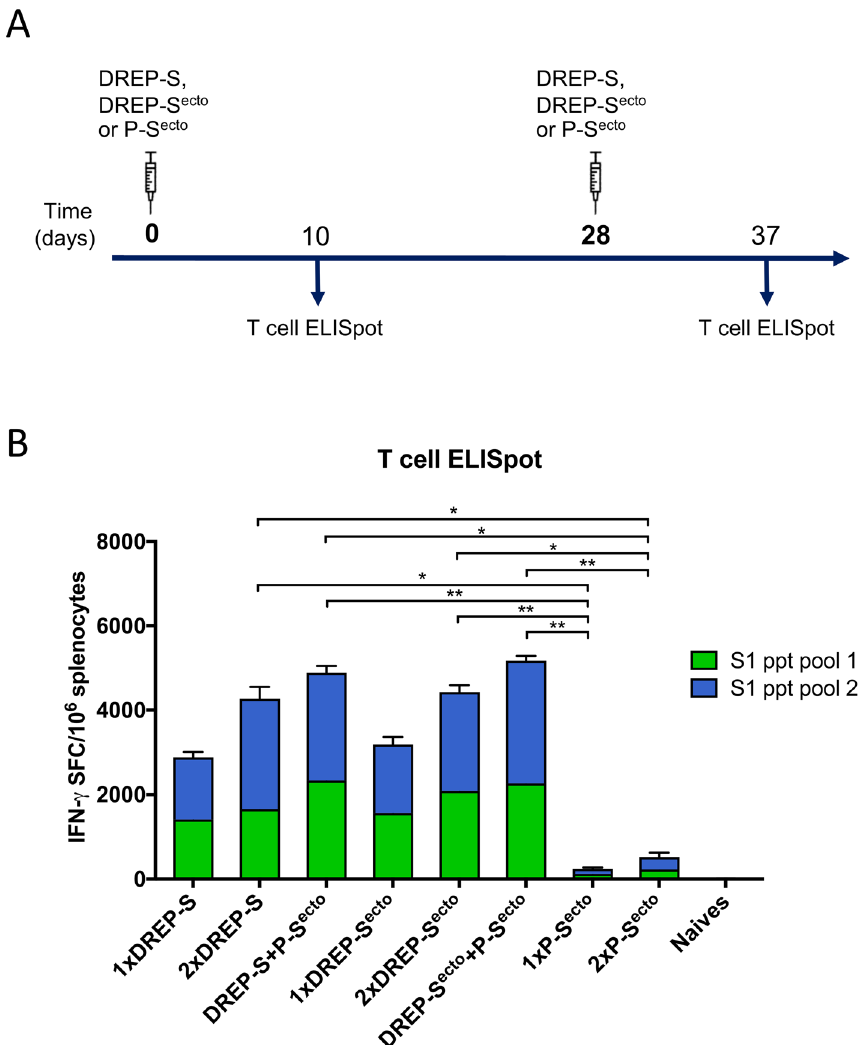
Figure 5. Analysis of S1-specific T cell responses. ( A ) Schematic representation of the experiment schedule. Mice were immunized on days 1 (prime) and 28 (boost) as indicated in the graph and spleens were collected 10 days after each immunization. ( B ) Quantification of IFN - γ secreting splenocytes upon restimulation with SARS-CoV-2 peptides. T cell responses were analyzed by ELISpot after restimulation of splenocytes with the SARS-CoV-2 S1 peptides (15-mers overlapping with 11 amino acids), covering the S1 domain of the spike glycoprotein. Pool 1, SARS-CoV-2 S1 peptides 1–83; pool 2, SARS-CoV-2 S1 peptides 84–166. Statistical analysis was performed comparing all groups except naïve controls using Kruskal Wallis test followed by Dunn’s test for multiple comparisons, * p < 0.05; ** p <